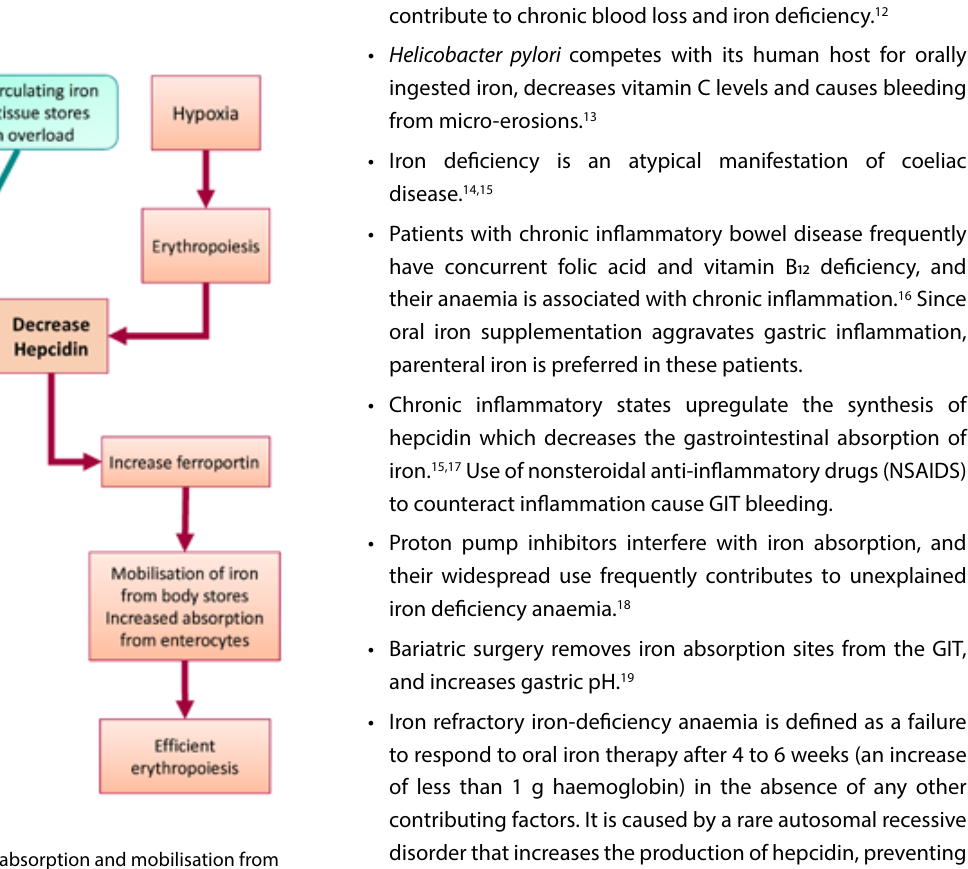
iron absorption. 20